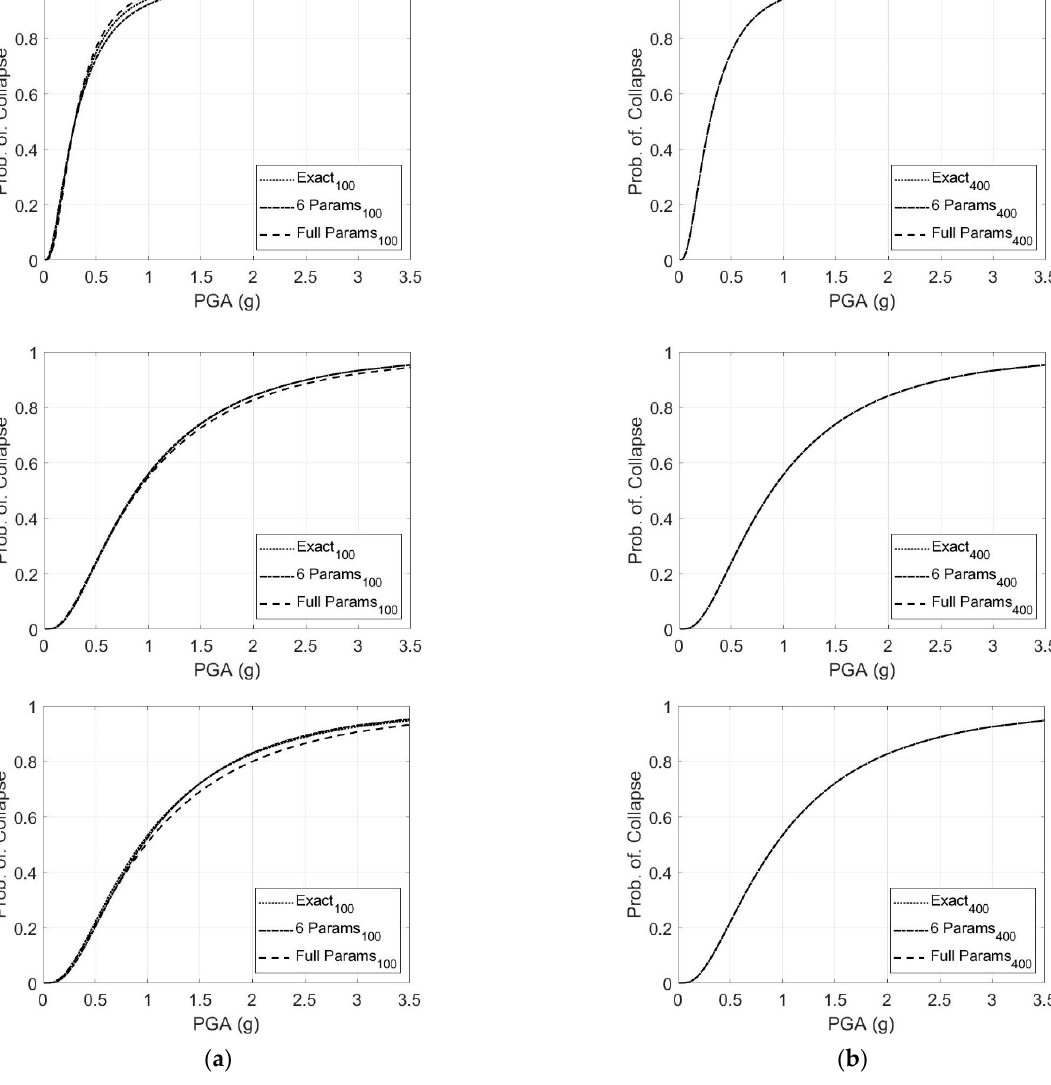
Figure 5. Fragility curves using 6-floor structure for ( a ) 100 sampling size with IO (upper left), LS (center left), and CP (lower left) levels, and ( b ) 400 sampling size with IO (upper right), LS (center right), and CP (lower right) levels.